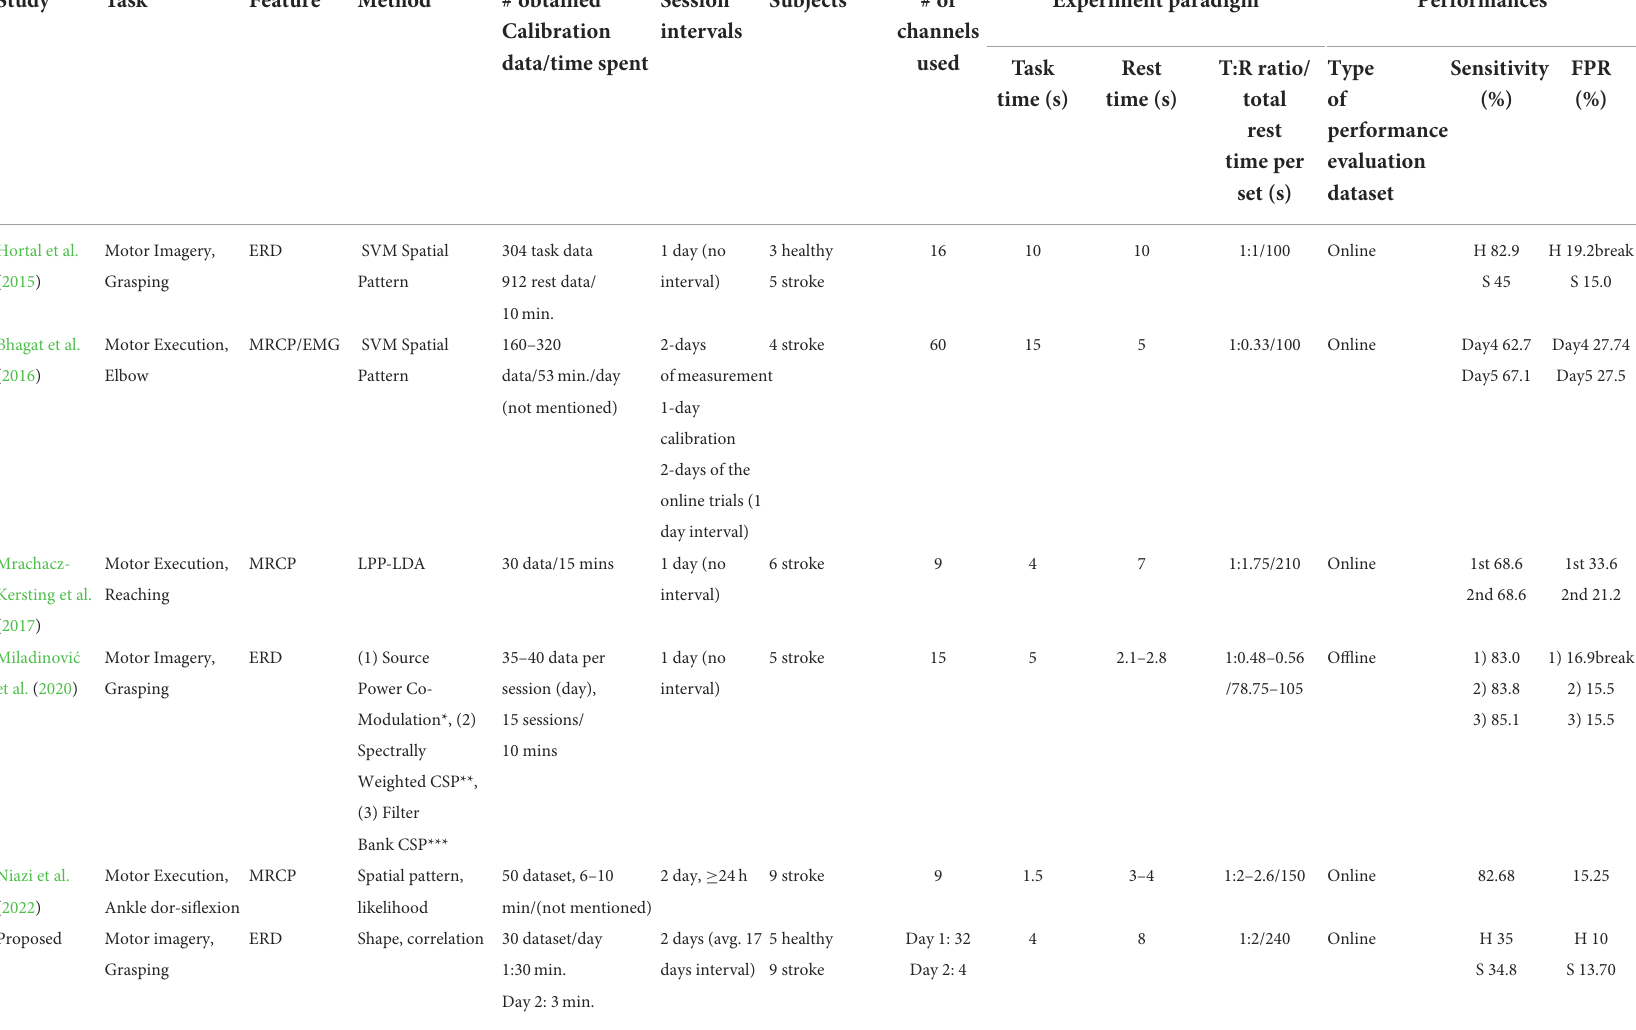
TABLE 5 Comparison of the method, experiment, and results with other studies applied to patients with stroke. Study